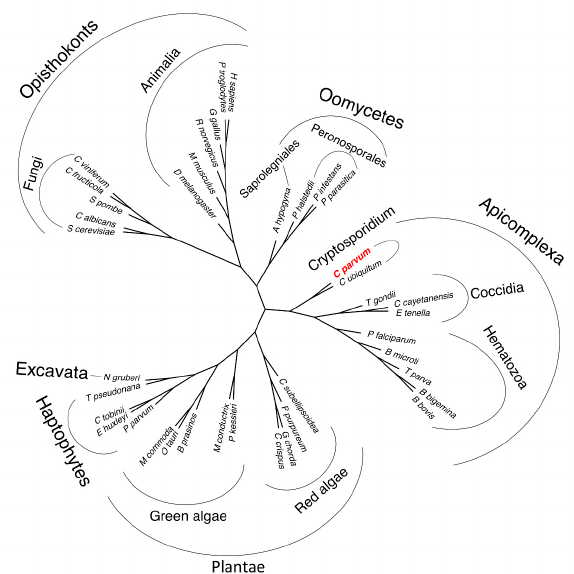
Figure 1. Phylogenetic relationship of mitosomal and mitochondrial ADP/ATP carriers. An unrooted phylogenetic tree of homologous mitochondrial and mitosomal ADP/ATP carrier sequences for a selection of eukaryotic organisms based on alignments. The tree was calculated using RAxML. The mitosomal ADP/ATP carrier of the parasite Cryptosporidium parvum is in an early branch of the Apicomplexa, as expected on the basis of species phylogeny.